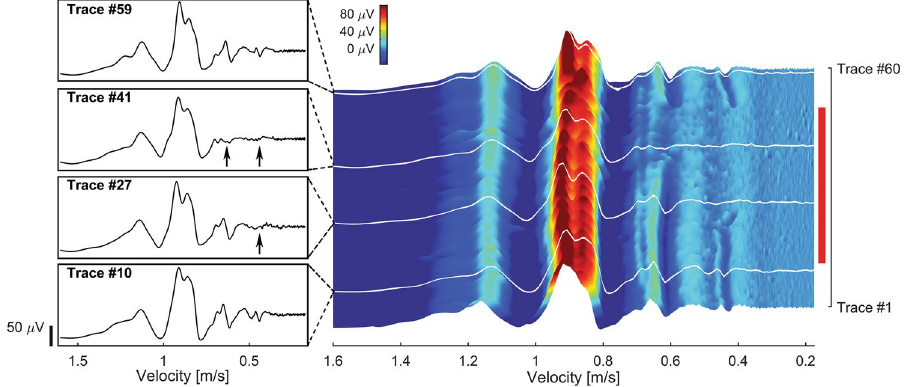
Figure 4. Selective block of slower-conducting CAP components in the Suncus murinus vagus nerve. (Left) Selected traces of vagal CAP corresponding to white lines on contour plot (right). (Trace 10) CAP before IR application. (Trace 27) CAP after IR application for 8.5 seconds. The slowest sub-population (~0.4 m/s) is inhibited (arrow). (Trace 41) CAP after IR application for 15.5 seconds. Both the slowest (~0.4 m/s) and intermediate velocity populations (~0.6 m/s) are inhibited (arrows). (Trace 59) CAP after removal of IR light; all CAP components are present, indicating reversibility. (Right) Contour plot of CAP traces (electrical stimulation frequency, 2 Hz) illustrating progressive preferential block of slow components during IR application (red vertical bar; on, trace 11; off, trace 51). Conduction velocity (m/s) is plotted against trace number. A color bar denotes trace voltages. For analysis of data, see Figure